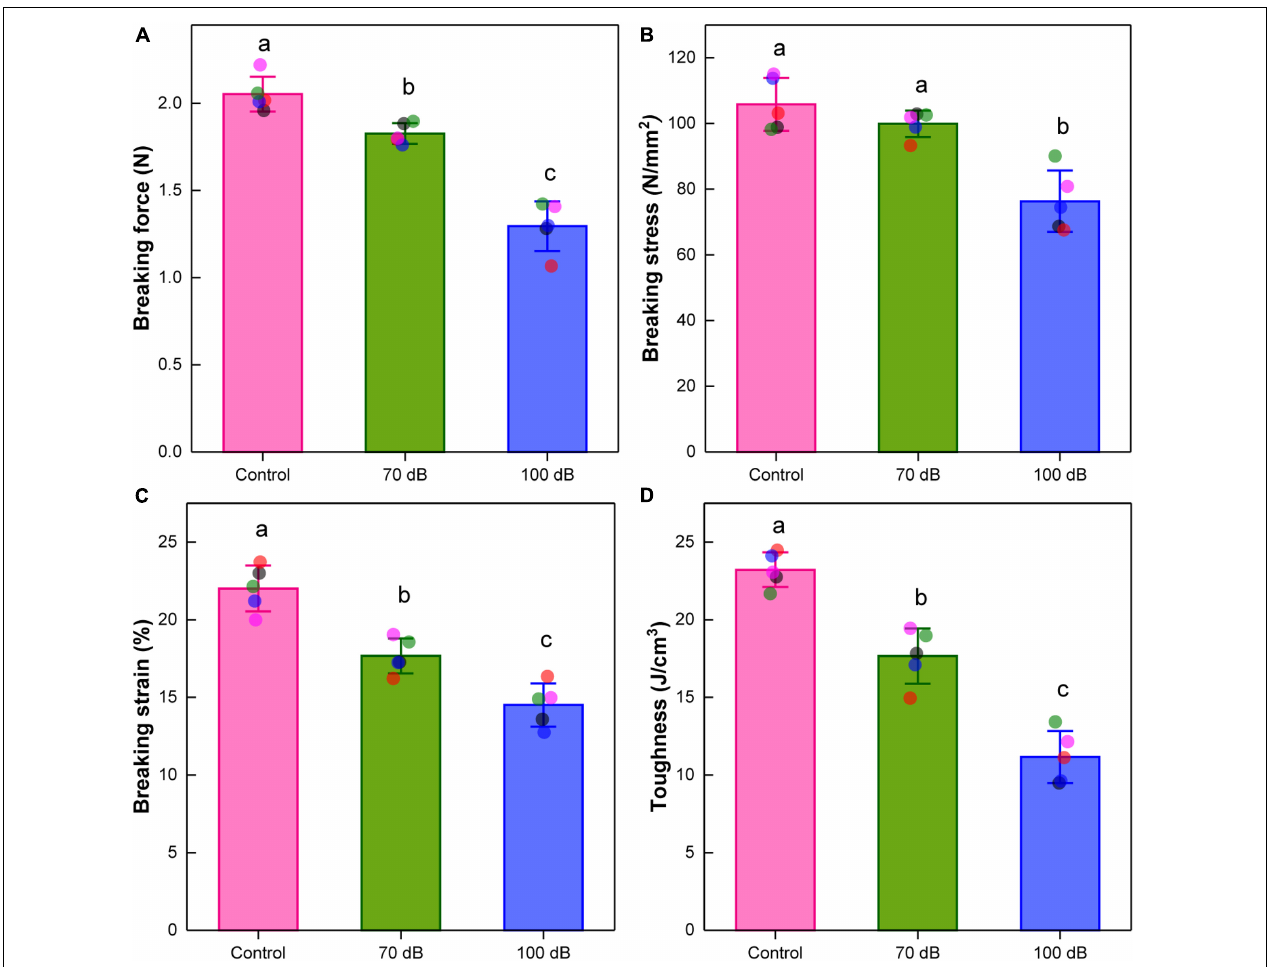
FIGURE 3 | Effects of anthropogenic noise exposure on the (A) breaking force, (B) breaking stress, (C) breaking strain, and (D) toughness of byssal threads newly produced by the thick shell mussel Mytilus coruscus ( n = 5 per group, mean ± SD). Means not sharing the same superscript are significantly different (Tukey’s HSD, p <